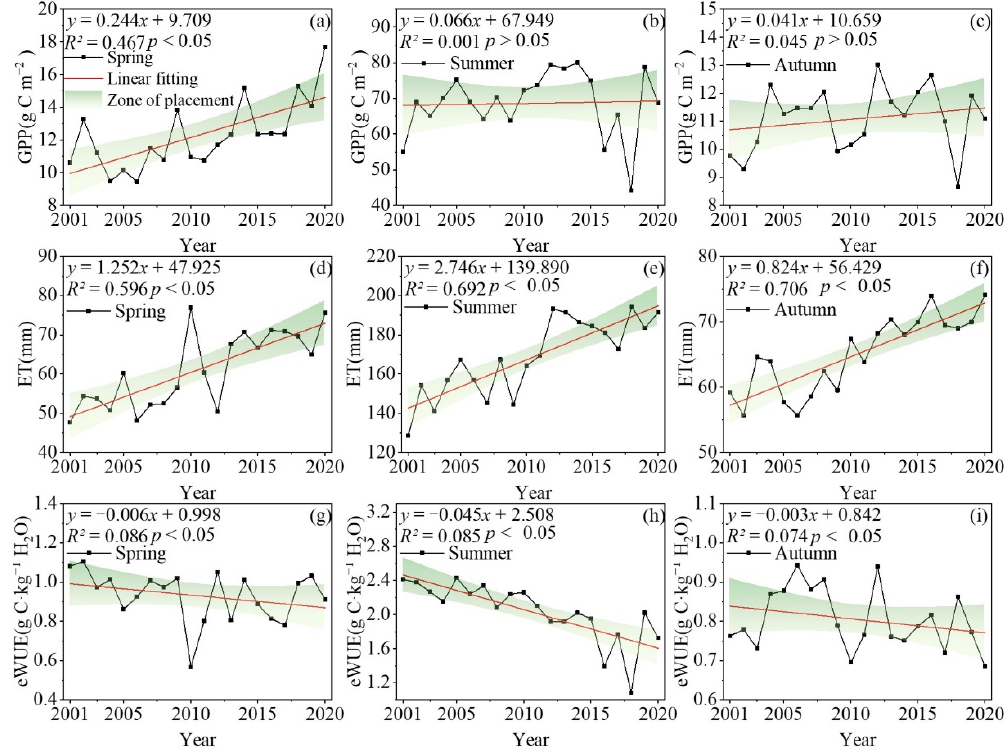
Figure 4. Seasonal temporal variation characteristics of gross primary productivity (GPP), evapotranspiration (ET) and eWUE in Inner Mongolia. ( a – c ) GPP for spring, summer and autumn, ( d – f ) ET for spring, summer and autumn, ( g – i ) eWUE for spring, summer and autumn.